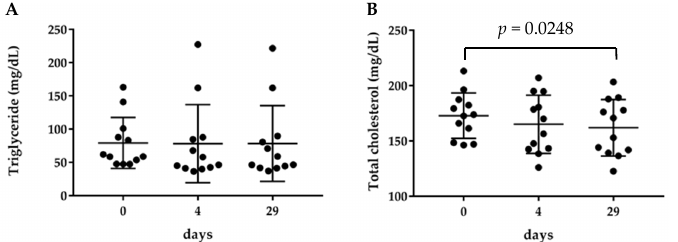
Figure 1. Changes in the levels of serum lipids. Level of ( A ) triglyceride and ( B ) total cholesterol. The data are presented as individual data with median and range, n =